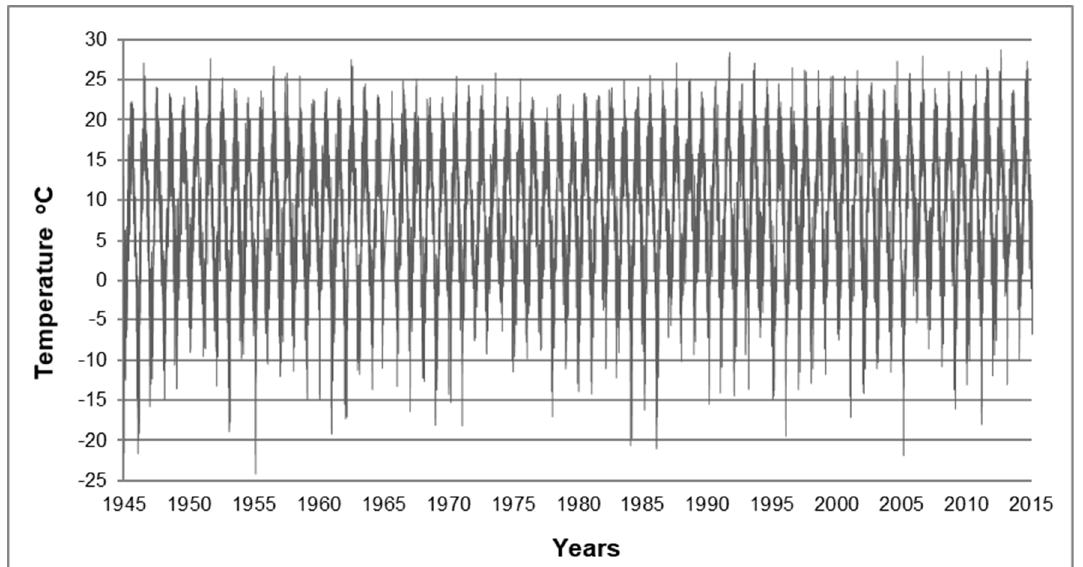
Figure 1. The course of average daily temperature values recorded at a meteorological station located a few kilometers from Auschwitz. Data Institute of Metrology in Warsaw.